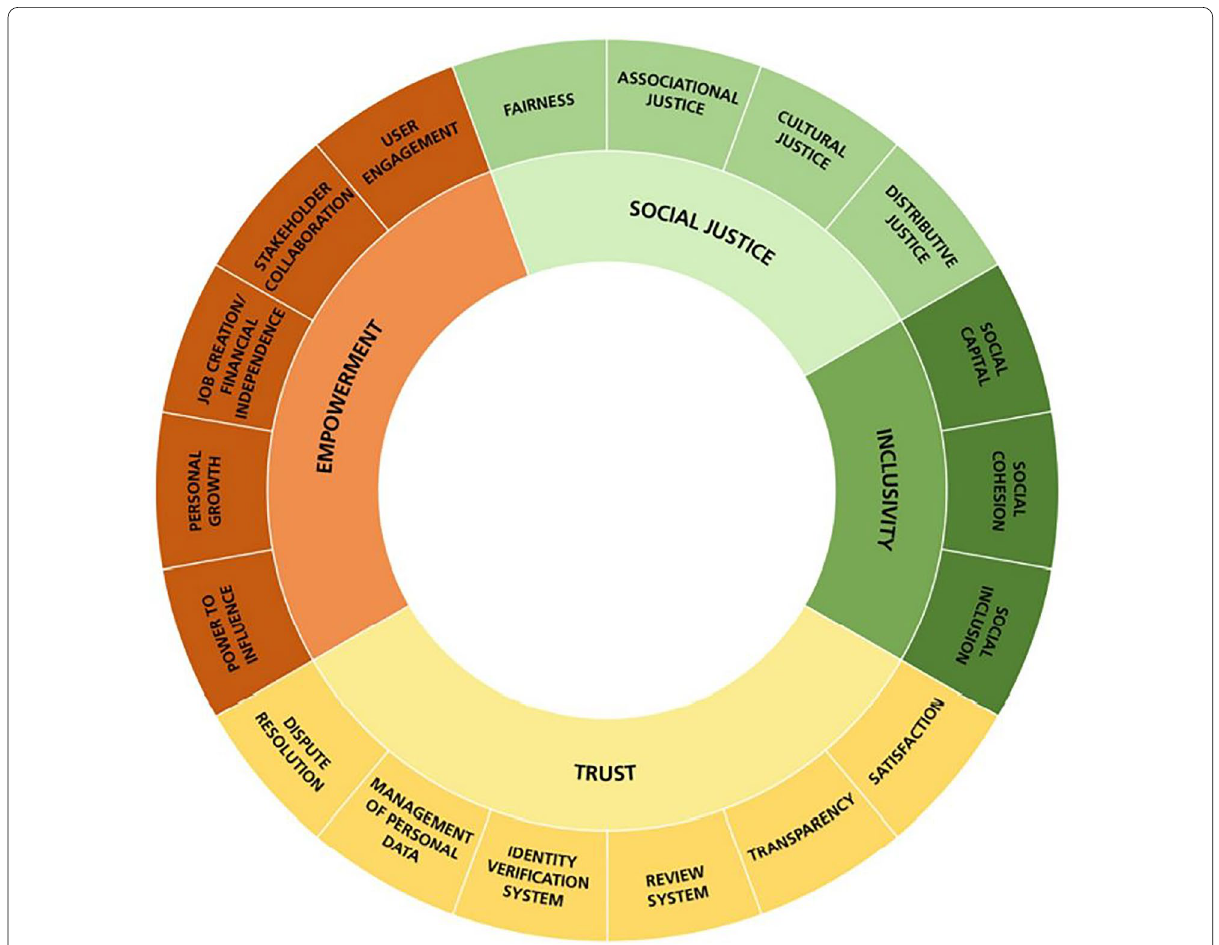
Fig. 12 Previous model ( source: Curtis et al.